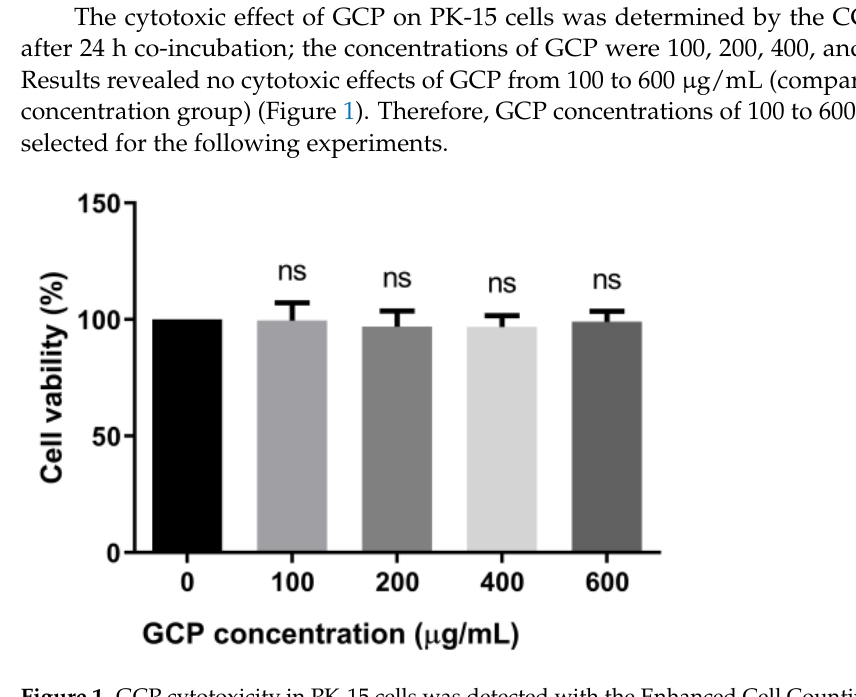
Figure 1. GCP cytotoxicity in PK-15 cells was detected with the Enhanced Cell Counting Kit-8. PK-15 cells were cultured in the presence of different concentrations of GCP for 24 h, and then added